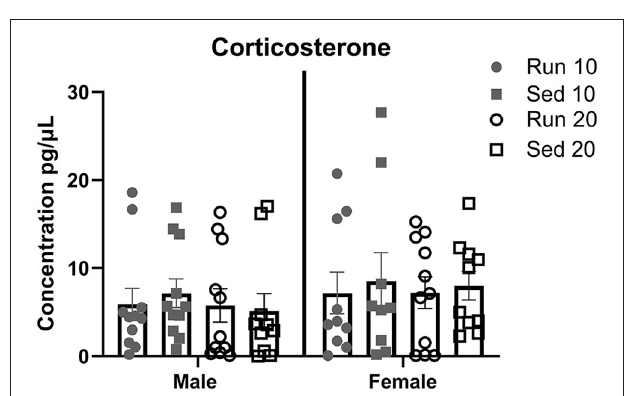
FIGURE 8 | Plasma Corticosterone. Male and female rats were placed in a locked or functional running wheel for 10 days and then euthanized. A 2nd cohort of rats were placed in a functional or locked running wheel for 10 days then rested in their homecage for an additional 10 days before euthanasia. Truck blood was collected at time of euthanasia and plasma was isolated. Corticosterone level were determined by ELISA. Run 10 = voluntary running wheels for 10 days ( n = 14/sex), Sed 10 = locked wheels for 10 days ( n = 14/sex), Run 20 = voluntary running for 10 days then rested in homecage 10 days ( n = 14/sex), Sed 20 = locked wheels for 10 days then rested in homecage for 10 days ( n = 14/sex). Data are presented as average ±